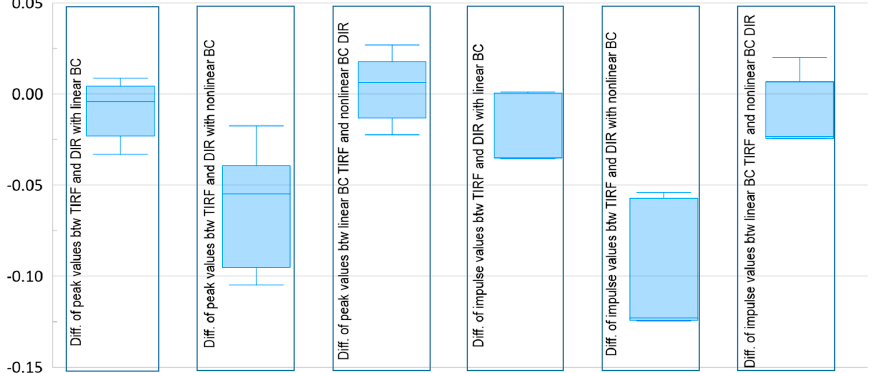
Figure 11. Box and whisker plots for the difference in the peak bending stresses and impulse values